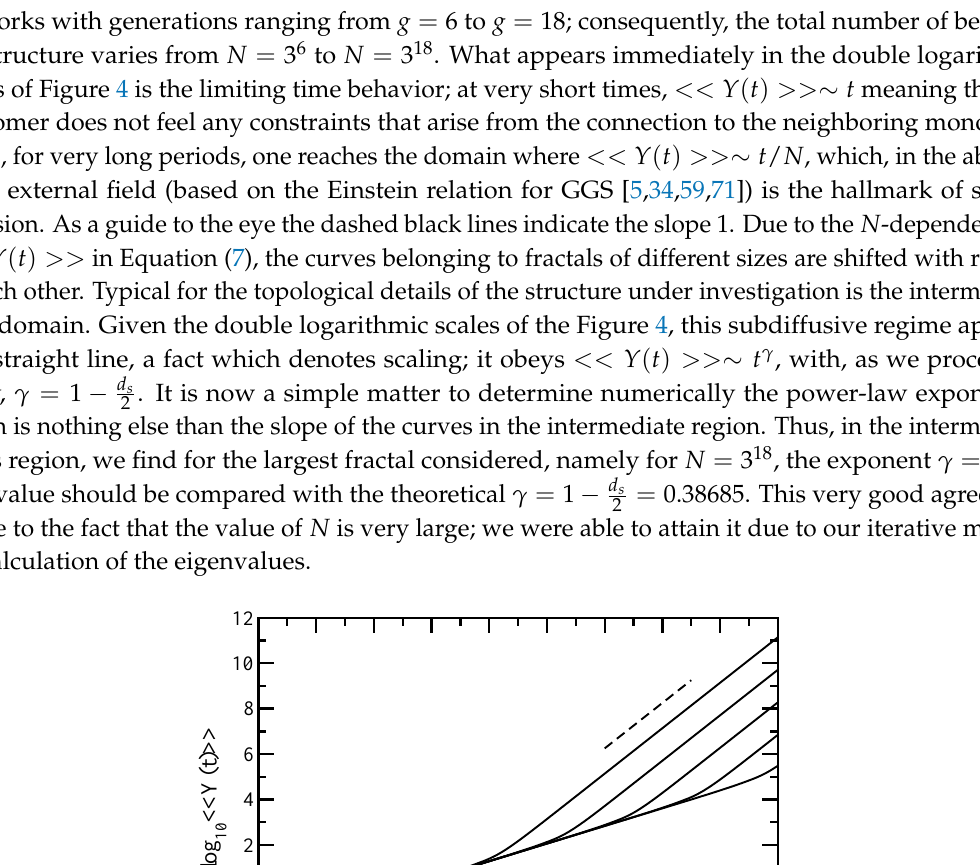
slope − 1. Our main focus is again the intermediate frequency region. In both figures, for each fractal object considered, this in-between region appears as a straight line that indicates power-law behavior. Going from N = 3 6 to N = 3 18 , we have a change in the minimal slope from 0.662 to 0.614 for G (cid:48) ( ω )